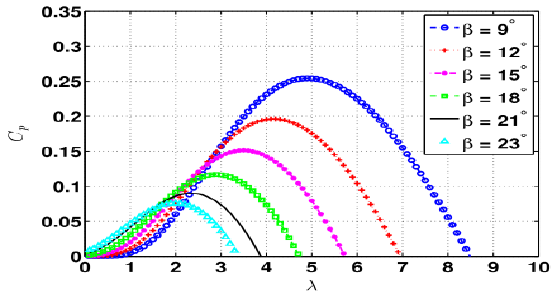
4 of 19 Figure 2. Two mass-model structure of considered wind turbine (WT). The total power of wind has a direct relation with wind speed as in the following equation [23]: (cid:1842) (cid:3024) = 1 2 (cid:2025)(cid:1827)(cid:1848) (cid:2871) (1) where (cid:2025) is the air density (kg/m 3 ), (cid:1827) is the swept area of the turbine (m 2 ), and (cid:1848) is the wind speed ( (cid:1865)/(cid:1871) ). It has been long proven that if the wind speed is zero after passing the turbine, the total wind energy will be absorbed by the turbine [23]. However, due to the wind loses, it is practically impossible to transfer all the energy. Due to this reason, the power coefficient ( (cid:1829) (cid:3017) ) is presented, which represents the aerodynamic efficiency of the wind turbine. Using (cid:1829) (cid:3017) , the aerodynamic power of the turbine ( (cid:1842) (cid:3028) ) can be expressed as follows: (cid:1842) (cid:3028) = 1 2 ∙ (cid:2025) ∙ (cid:1829) (cid:3017) ∙ (cid:1827) ∙ (cid:1848) (cid:2871) (2) The power coefficient is a nonlinear function that depends on two paramount factors: the tip speed ratio ( (cid:2019) ) and the blade pitch angle ( (cid:2010) ) as in the following numerical equation: (cid:1829) (cid:3043) ((cid:2019) . (cid:2010)) = 0.5176 (cid:3436)116 (cid:2019) (cid:3036) − 0.4(cid:2010) − 5(cid:3440) (cid:1857) (cid:2879)(cid:2870)(cid:2869)/(cid:3090) (cid:3284) + 0.0068 (3) The parameter (cid:2019) (cid:3036) can be calculated as follows: 1 (cid:2019) (cid:3036) = 1 (cid:2019) + 0.08(cid:2010) − 0.035 (cid:2010) (cid:2871) + 1 (4) The parameter (cid:2019) is calculated by the blade tip speed and wind speed upstream of the rotor as: